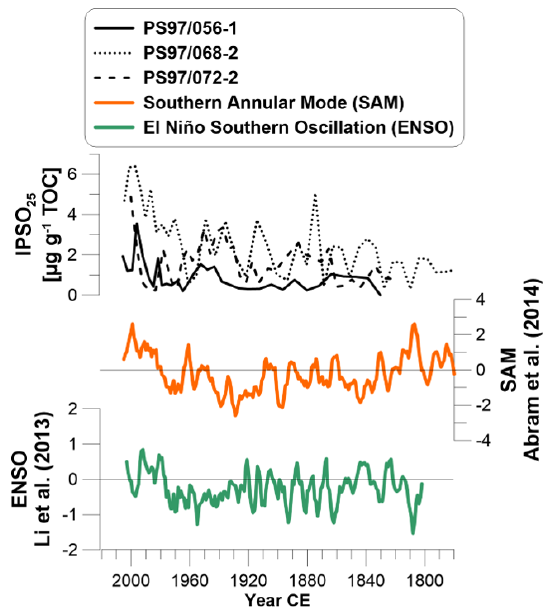
Figure 7. Concentrations of biomarker IPSO 25 in all three sediment cores compared to the circulation pattern of the Southern Annular Mode (SAM; 5-year running mean; Abram et al., 2014) and the El Niño–Southern Oscillation (ENSO; 5-year running mean; Li et al.,